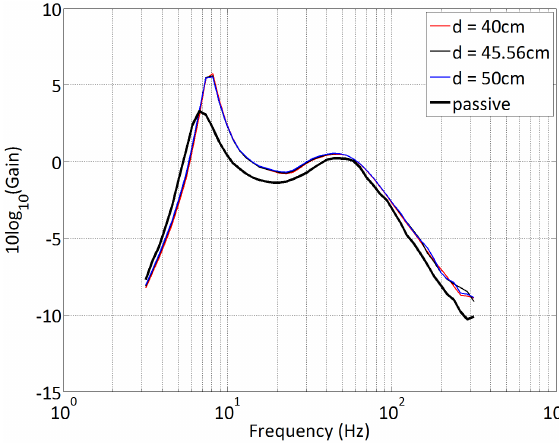
Figure 15. Frequency Domain Simulation: Suspension Deflection